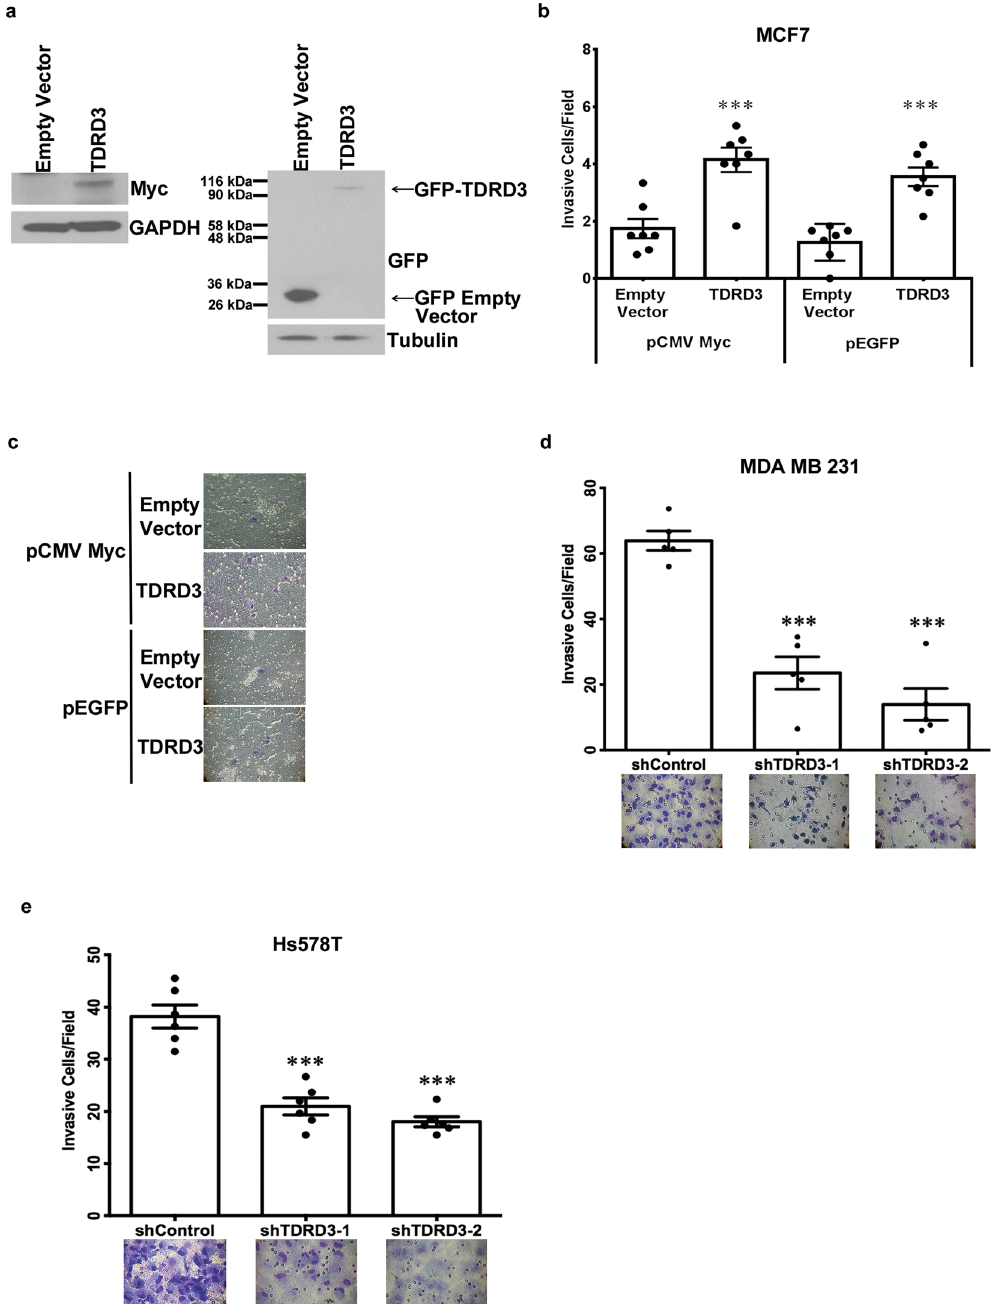
Figure 2. TDRD3 Promotes Cell Invasion in Breast Cancer Cells. ( a ) MCF7 cells were transiently transfected with Myc-tagged TDRD3 or empty vector (left panel) and GFP-tagged TDRD3 or empty vector (right panel) for 48 h and Western blotting was performed ( b ) Invasive cells/field for Myc-tagged TDRD3 or empty vector (n = 7, *** p = 0.0008) and GFP-tagged TDRD3 or empty vector (n = 7, *** p = 0.0001) cells placed in Transwell chambers for 72 h. Data is the mean + / − SEM. Significance was determined using a two-tailed t -test. ( c ) Images of Transwell chambers transiently transfected with Myc-tagged TDRD3 or empty vector and GFP-tagged TDRD3 or empty vector (Magnification, 40X). Invasive cells/field of ( d ) MDA MB 231 (n = 5, *** p < 0.0001) or ( e ) Hs578T (n = 6, *** p < 0.0001) shControl, shTDRD3-1 or shTDRD3-2 stable cell lines placed in Transwell chambers for 24 h. Data is the mean + / − SEM. Images of invasive cells (Magnification, 40X) are depicted below graph. Significance was determined using a one-way